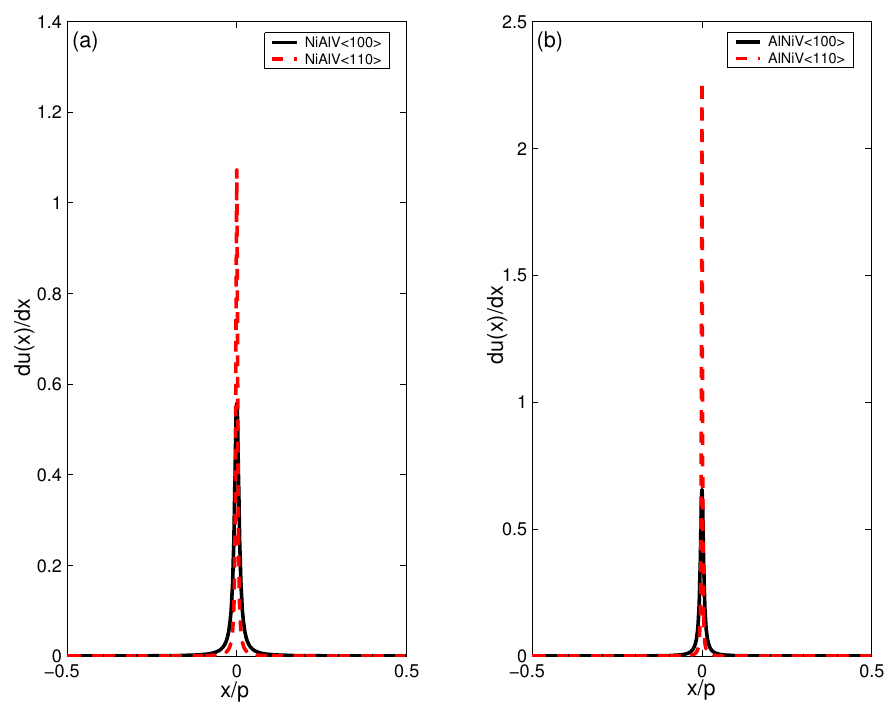
Figure 6. The density of misfit dislocations: ( a ) NiAlV interface and ( b ) AlNiV interface for Burgers vector along (cid:104) 100 (cid:105) and (cid:104) 110 (cid:105) ,